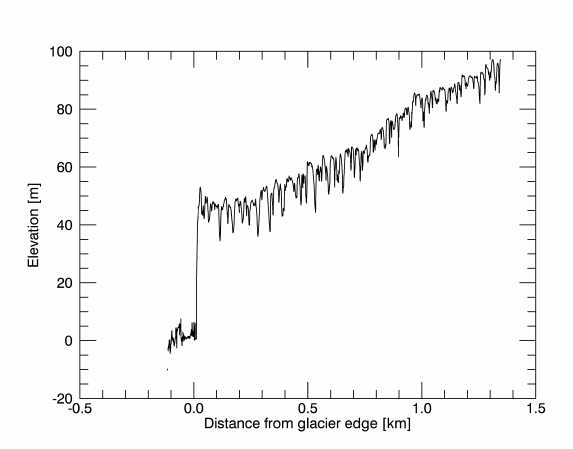
Figure 5: Elevation profile along the glacier centerline retrieved from the DEM shown in figure 4.